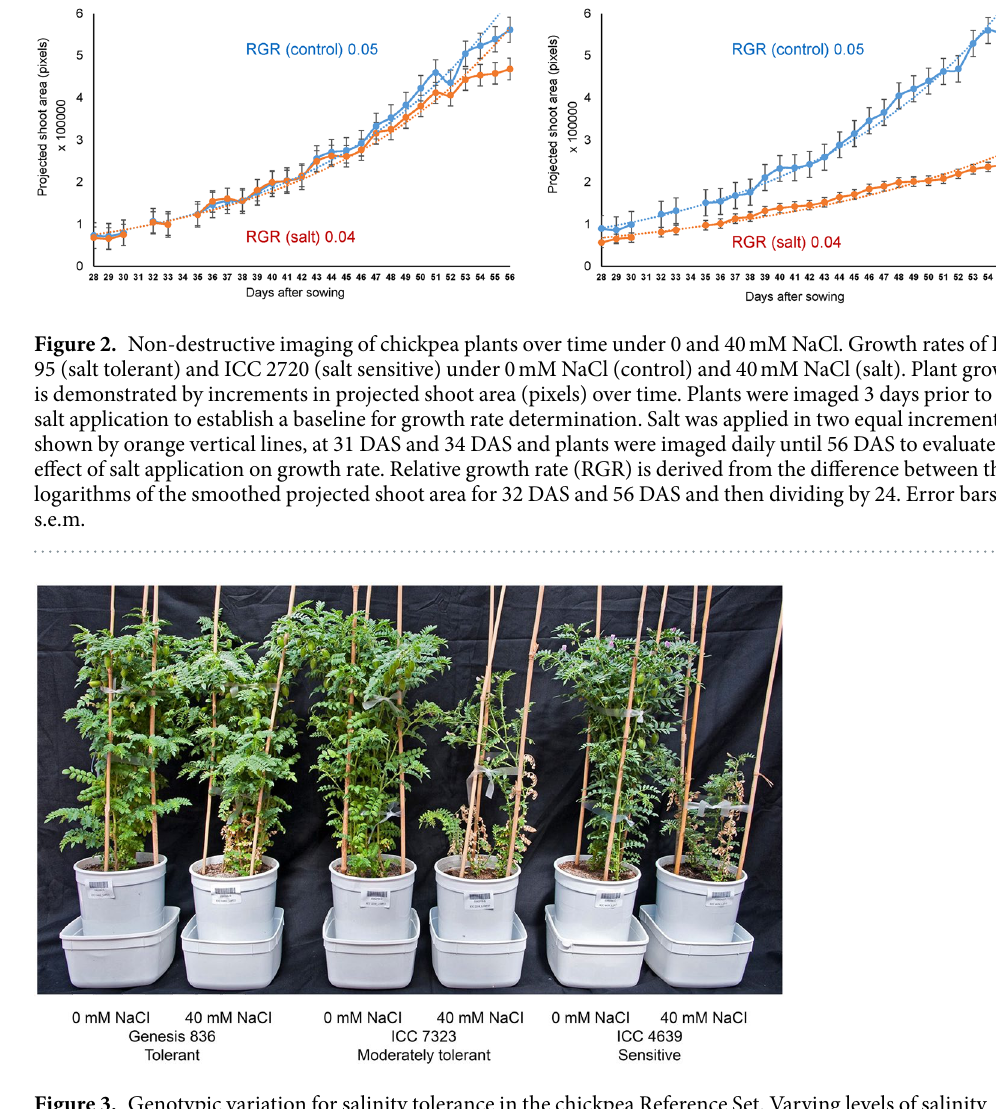
Figure 3. Genotypic variation for salinity tolerance in the chickpea Reference Set. Varying levels of salinity tolerance exhibited by different chickpea genotypes. Exposure of sensitive genotypes to 40 mM NaCl caused severe stunted growth, leaf damage, and led to less number of reproductive sites (flowers and pods) compared to moderately tolerant and tolerant genotypes.